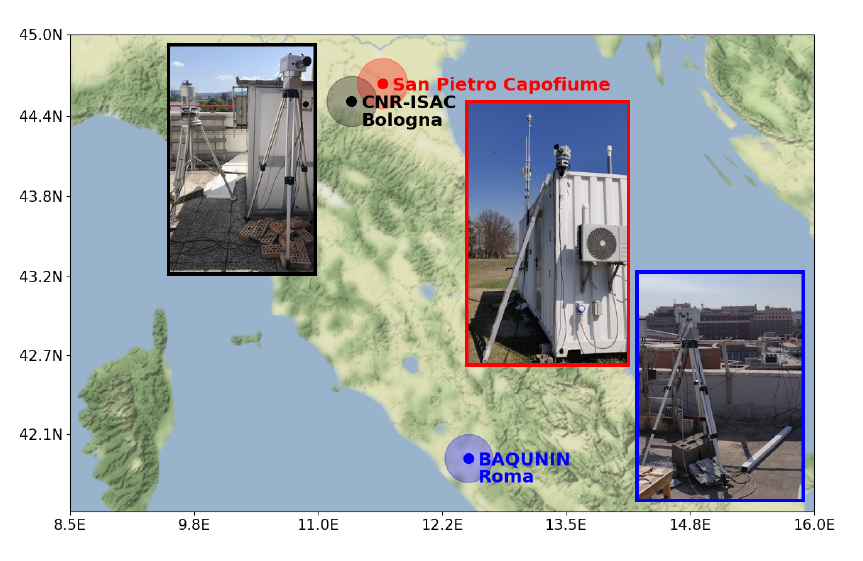
Figure 1. Location of the CNR-ISAC in Bologna (black), of the San Pietro Capofiume “Giorgio Fea” observatory (red) and of the BAQUNIN super-site in Rome (blue). Photos of the instruments in the three locations are also shown.